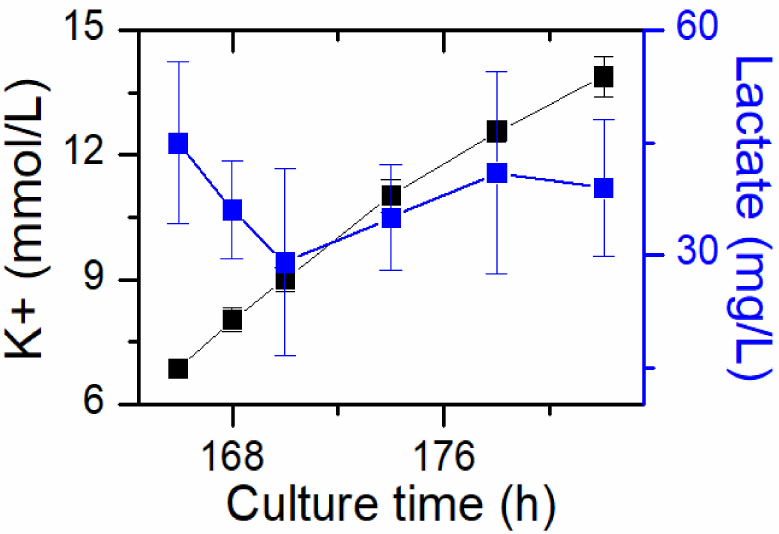
Figure 3. Impact of glucose withdrawal on cell culture metabolite profiles in the stationary phase. Data are expressed as mean ± standard error of three